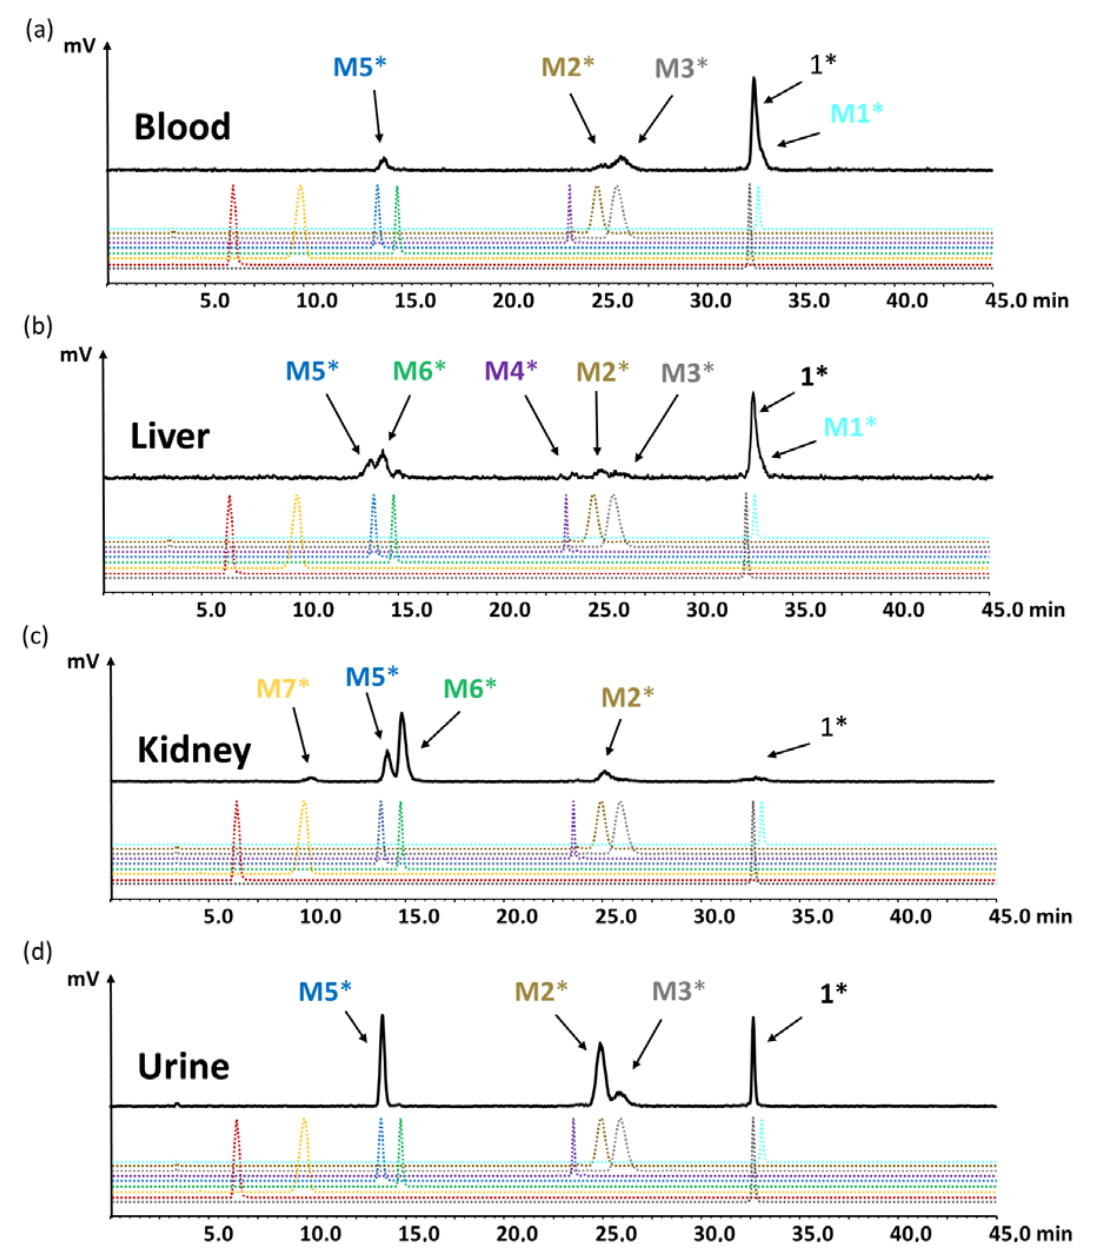
Figure 8. Radiochromatograms obtained from ( a ) blood, ( c ) liver, ( d ) kidneys and ( b ) urine of BALB/c mice injected with [ 177 Lu]Lu- 1 for the time point of 60 min p.i.; radiochromatograms of 177 Lu-labeled peptides 1 and M1 – M8 are shown for comparison (* indicating radiolabeled with lutetium-177).